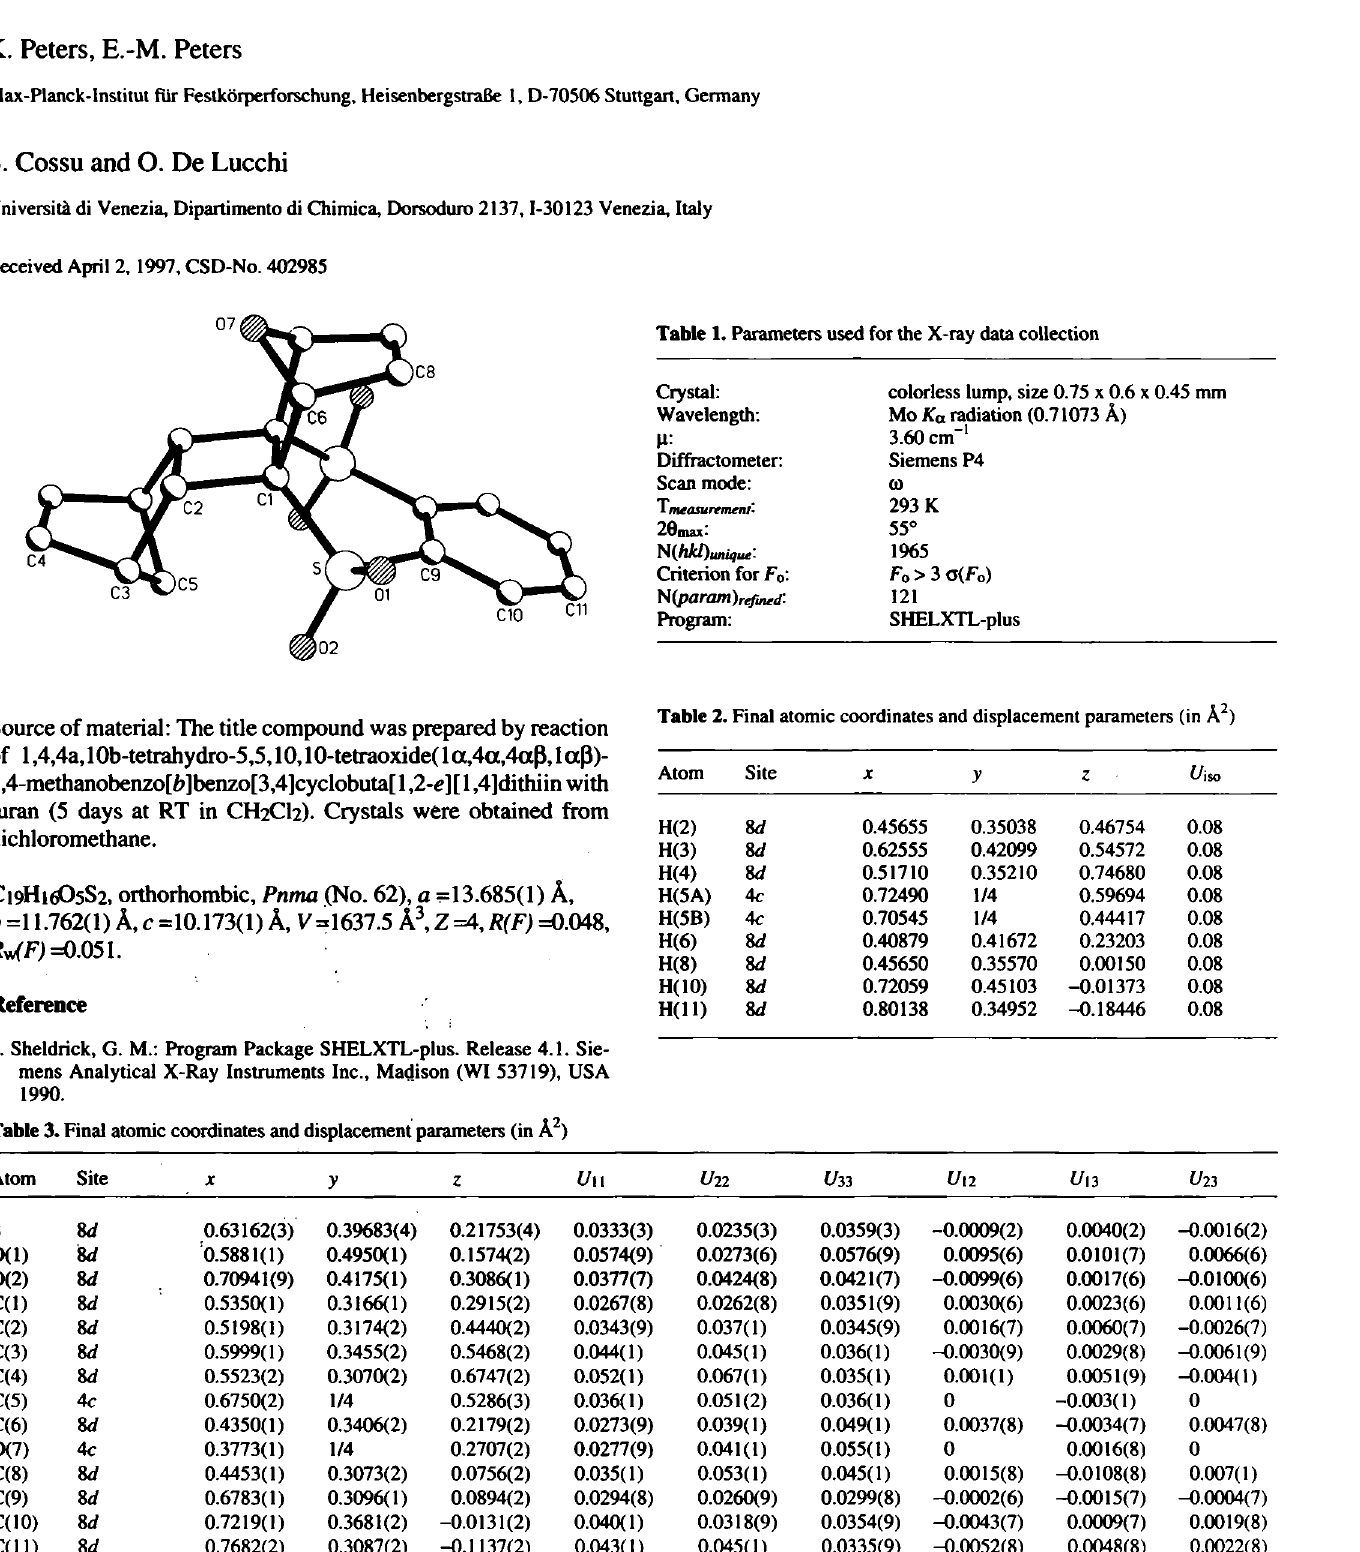
Table 1. Parameters used for the X-ray data collection Crystal: